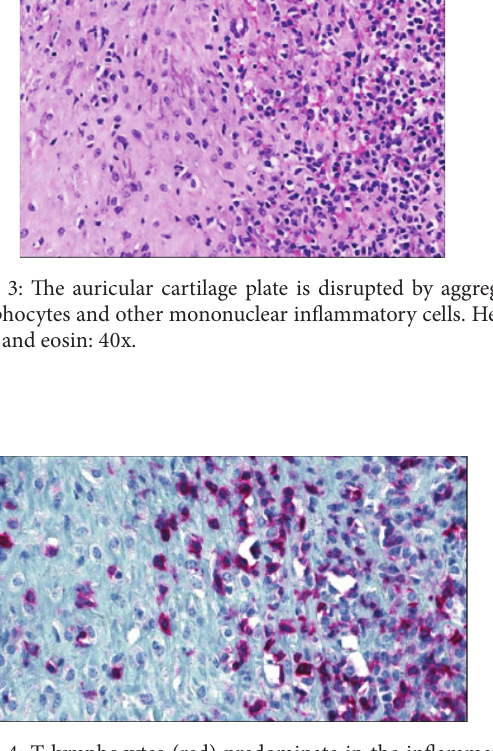
Figure 4: T-lymphocytes (red) predominate in the inflammation. Immunohistochemistry for CD3; avidin-biotin-peroxidase method with NovaRed chromogen and hematoxylin counterstain